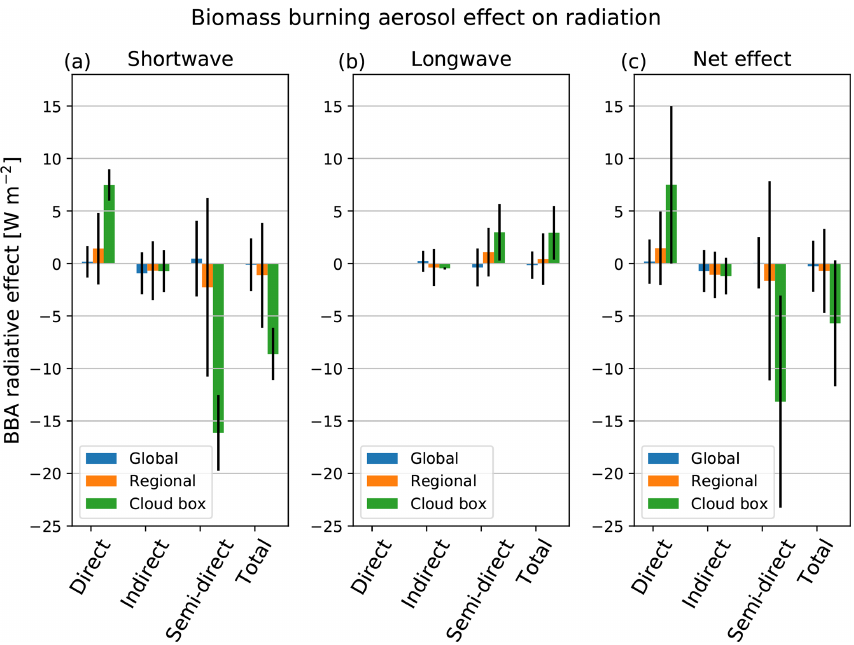
Figure 10. Bar chart of UKESM1 mean BBA radiative effect during July and August 2016–2017. The BBA radiative effect at the (a) shortwave and (b) longwave as well as the (c) net effect are presented in separate plots. Blue represents the global mean; orange is the domain mean, and green is the cloud box mean. The error bars represent standard